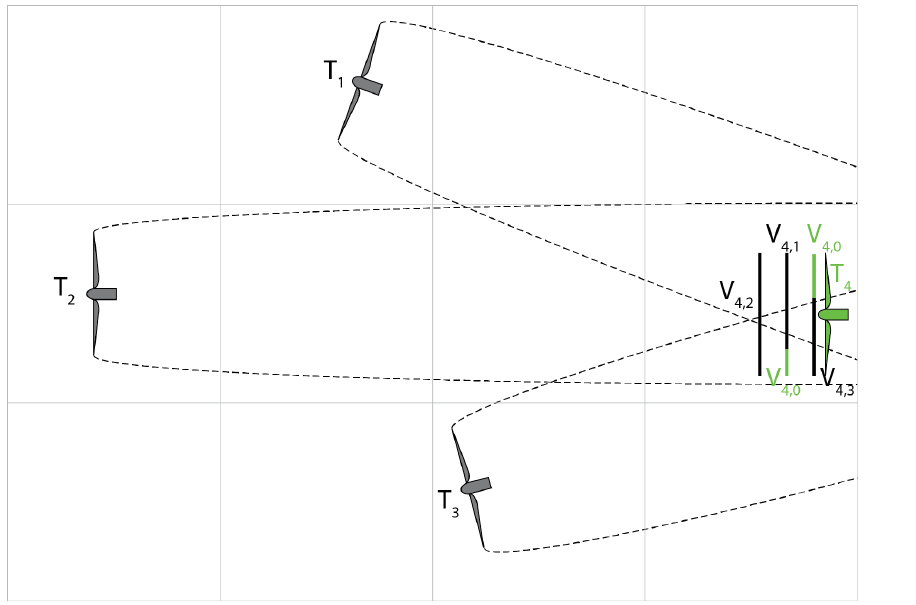
Figure 1. Example of how wake overlapping is accounted for with method M4. The four turbines T 1 –T 4 are in different grid cells; T 4 is affected by three wakes, each affecting a different portion of its rotor (the thick black line is the affected portion of the rotor, and the thick green line is the undisturbed portion) and causing a different wind speed; the resulting wind speed is proportional to the summation of the wind speeds caused by each upstream turbine i , i.e., V 4 ,i , using Eq.